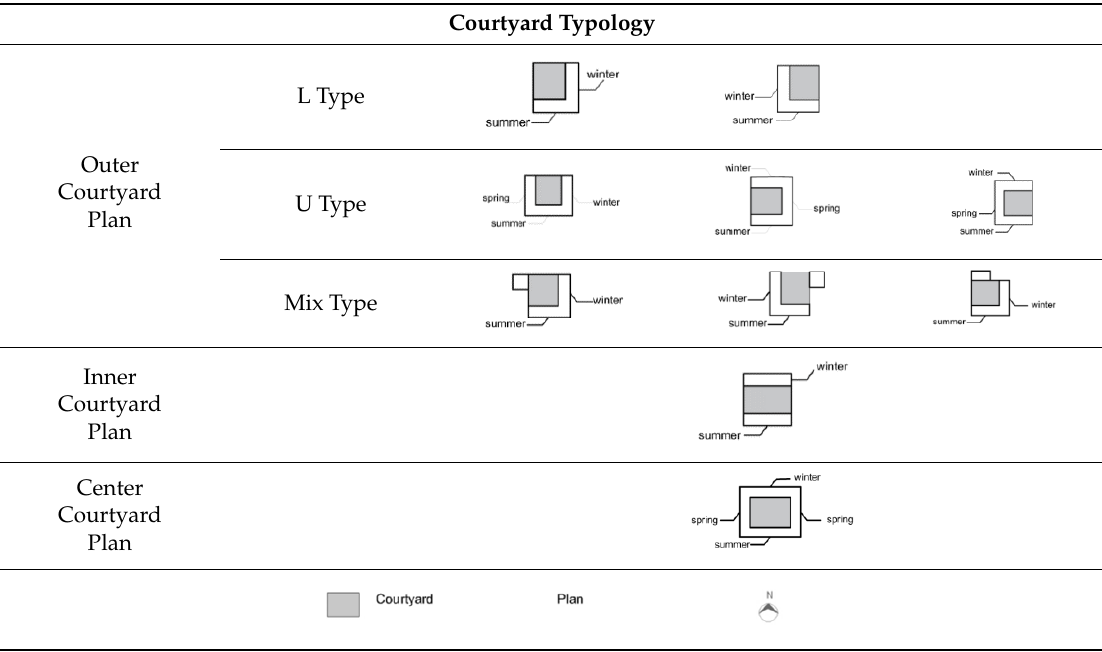
Table 4. Orientations used according to housing plan types in Diyarbakır [19].